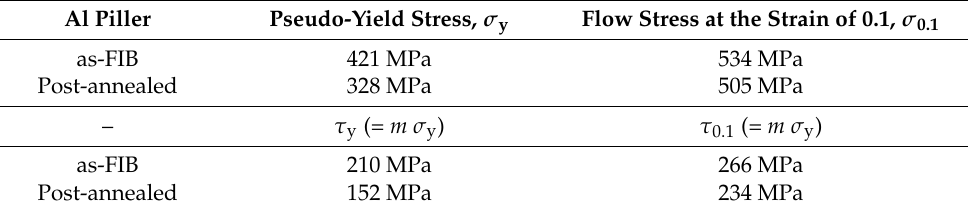
Table 1. Mechanical properties of the Al pillar obtained by TEM in situ compression measurement. The stresses ( σ y and σ 0.1 ) were measured from the S–S curves. The resolved shear stresses ( τ y and τ 0.1 ) were evaluated by the slip system activating during the TEM in situ experiments. The activating slip system has the highest Schmidt factors ( m ), namely 0.4988 (as-FIB) and 0.4634 (Post-annealed).